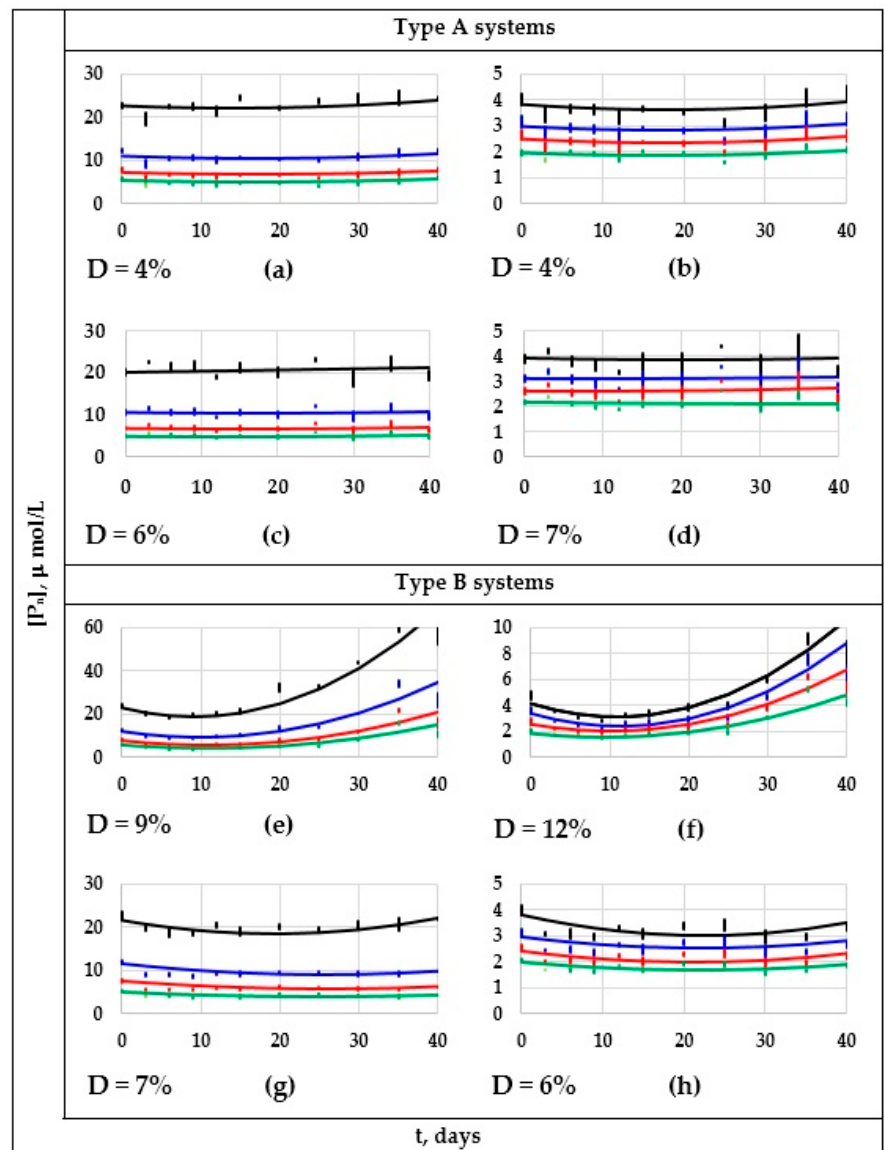
Figure 4. P n vs. t -fitted curves and experimental “error bars” for the four extreme “type A systems” (F1-P6 and F3-P7) or “type B systems” (F1-P1 and F2-P3). “Type A systems”: F1-P6 system ( a , b ), and F3-P7 system ( c , d ); for ( a , c ): n = 6 (black lines), 8 (blue lines), 10 (red lines), and 12 (green lines), whereas for ( b , d ): n = 14 (black lines), 16 (blue lines), 18 (red lines) and, 20 (green lines). “Type B systems”: F1-P1 system ( e , f ), and F2-P3 system ( g , h ); for ( e , g ): n = 6 (black lines), 8 (blue lines), 10 (red lines), and 12 (green lines), whereas for ( f , h ): n = 14 (black lines), 16 (blue lines), 18 (red lines) and, 20 (green